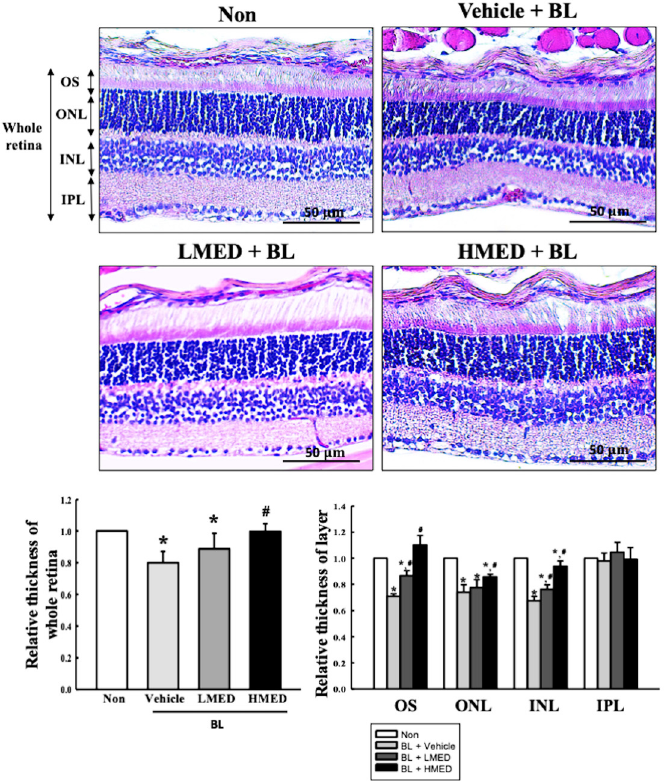
Figure 11. Histopathological structures in the retina of MED + BL treated Balb/c mice. H&E-stained sections of the retina were observed at 200× magnification using an optical microscope. The degree of histopathological changes in the retina tissue was measured by Image J program. The H&E- stained slides were prepared from three to five mice per group, the histopathological parameter analyses for each sample were measured in duplicate. All values in results are represented as the means ± standard deviation (SD). * indicated statically significance compared to the Non treated group, while # indicated statically significance compared to the Vehicle + A2E + BL treated group.